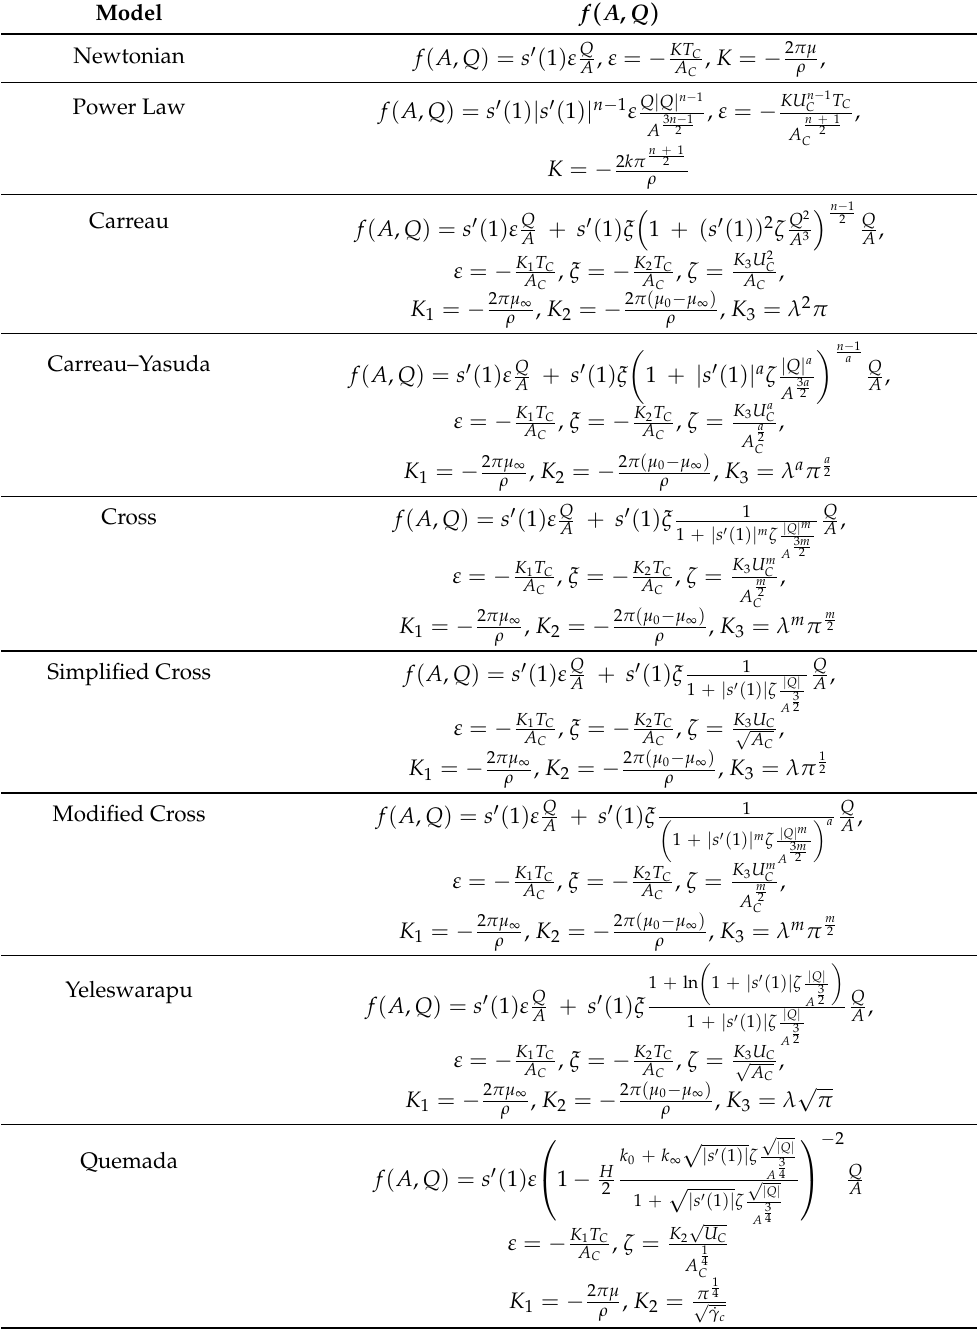
Table 2. Expressions for the frictional